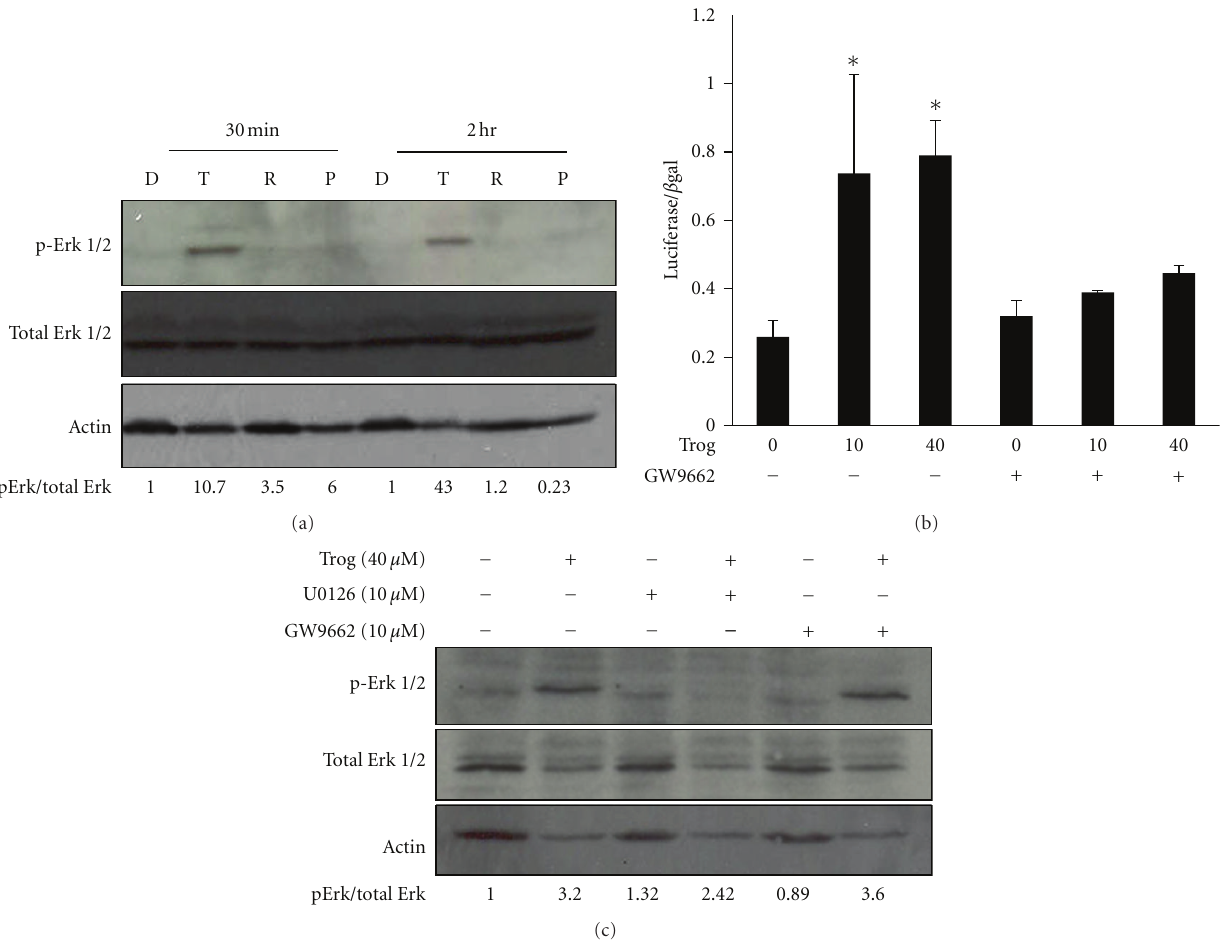
Figure 3: Troglitazone-stimulated increases in Erk phosphorylation occur independently of PPAR γ . (a) PC-3 cells were treated for 30 minutes or two hours with DMSO vehicle control (D) or the PPAR γ ligands troglitazone (T; 40 μ M), rosiglitazone (R; 40 μ M), or pioglitazone (P; 30 μ M). The level of ERK 1/2 (both total and phosphorylated) and actin was then detected by Western blot analysis. (b) PC-3 cells were first transfected with the PPRE-luciferase and CMV- β -galactosidase reporter plasmids. Cells were then treated for 24 hours with DMSO vehicle or troglitazone (10 or 40 μ M) in the presence or absence of the PPAR γ antagonist GW9662 (10 μ M). The level of luciferase activity in treated cells was measured and normalized to β -galactosidase activity. Each bar represents the mean SD for three wells. ∗ P < 0 . 05 compared to vehicle control (0 Trog, − GW9662). (c) PC-3 cells were treated for two hours with DMSO vehicle ( − ) or 40 μ M troglitazone (+) in the presence or absence of the MEK inhibitor U0126 (10 μ M) or the PPAR γ antagonist GW9662 (10 μ M). Western blotting was then used to measure Erk and actin levels within treated cells. The data from each blot were quantified and expressed relative to the signal present in the vehicle control sample ( − Trog, − U0126, −